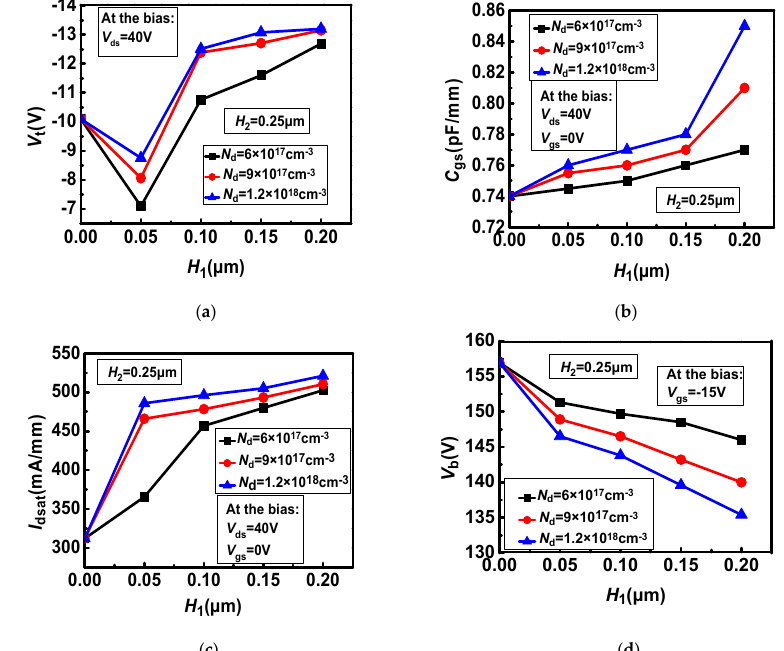
Figure 3. The effect of H 1 and N d on the device parameters: ( a ) V t – N d and H 1 , ( b ) C gs – N d and H 1 , ( c )